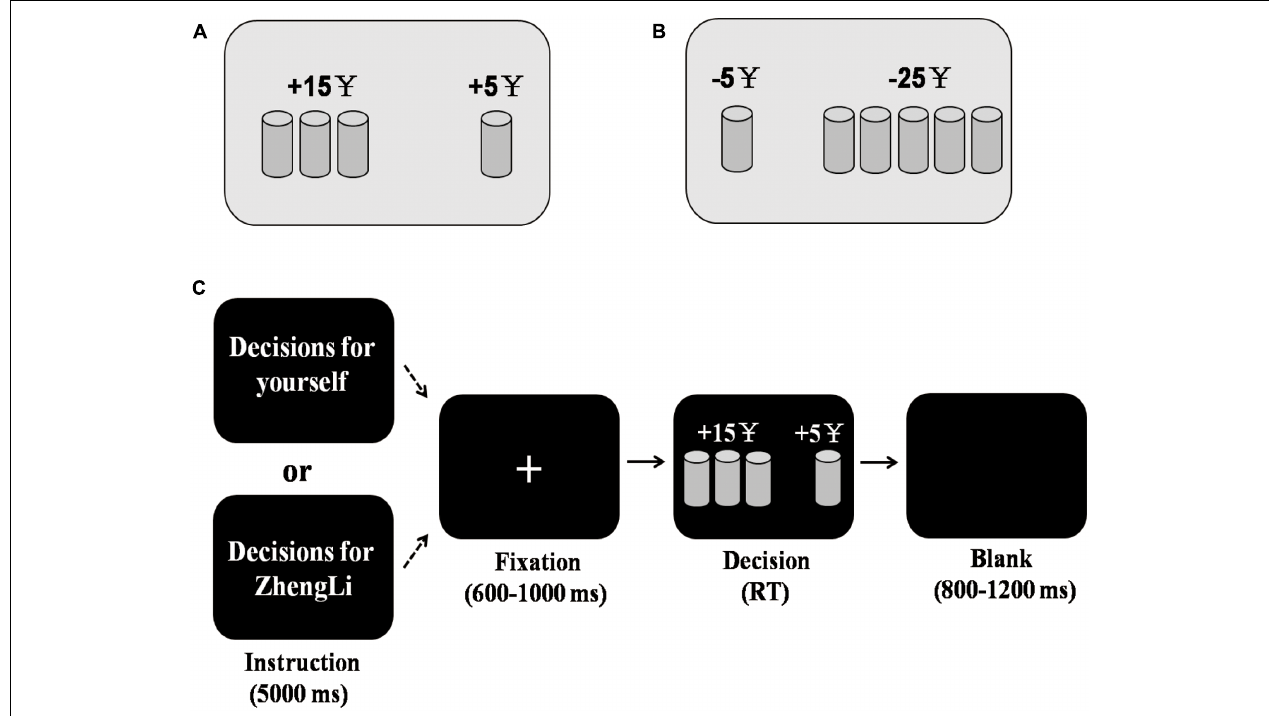
FIGURE 1 | Illustration of the cups task and experimental procedure. (A) A gain situation. The risky option was presented on the left side of the screen, with a 0.33 chance of gaining (cid:85) 15 or a 0.67 possibility of gaining nothing. The sure option was presented on the right side of the screen, with a certainty of gaining (cid:85) 5. (B) A loss situation. The risky option was presented on the right side of the screen, with a 0.20 probability of losing (cid:85) 25 or a 0.80 probability of losing nothing. The sure option was presented on the left side of the screen, with a certainty of losing (cid:85) 5. (C) Experimental procedure. In each block, an instruction was presented only at the first trial indicating whether the subsequent series of decisions were made for oneself or for another person (i.e., ZhengLi). During the decision phase, the gain and loss domain trials were presented in a pseudo-random order within each